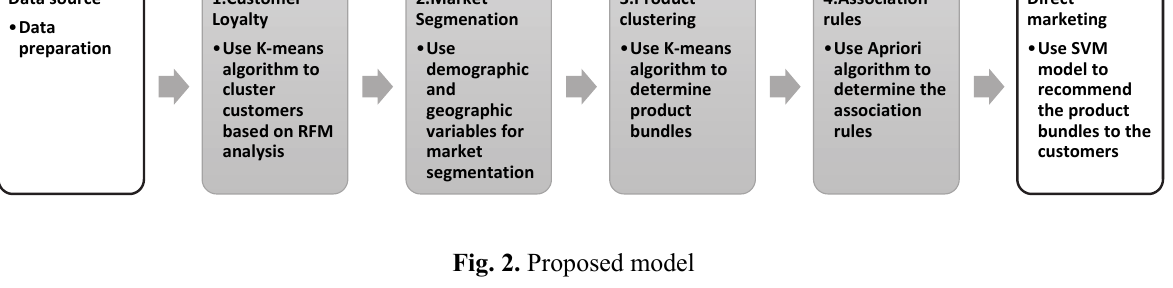
Fig. 2. Proposed model